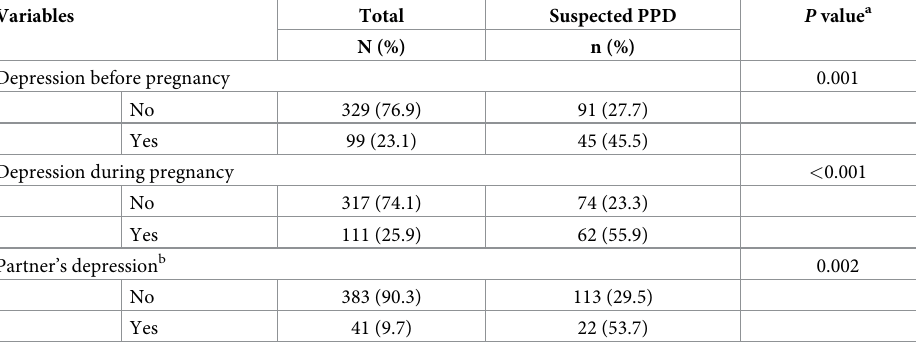
Table 4. Bivariate analysis of history of depression and suspected PPD among postpartum women and their partners.